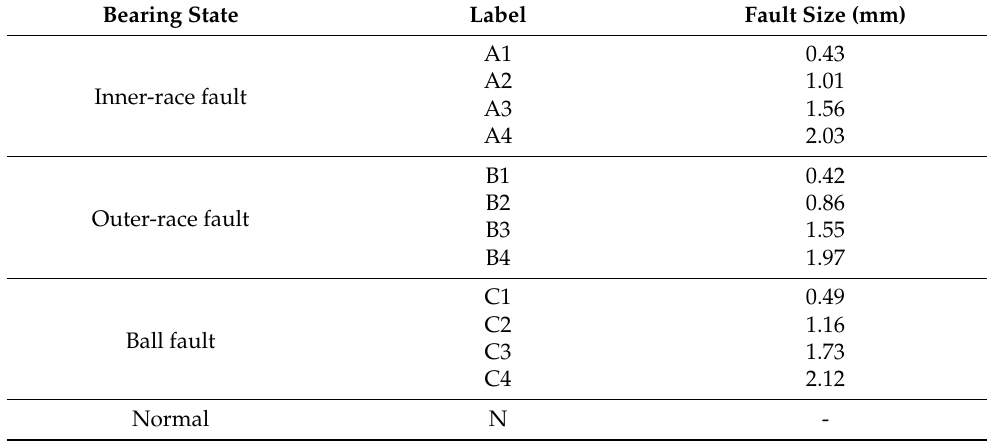
Figure 18. Testbed of Case 2. Table 7. The composition of the dataset.